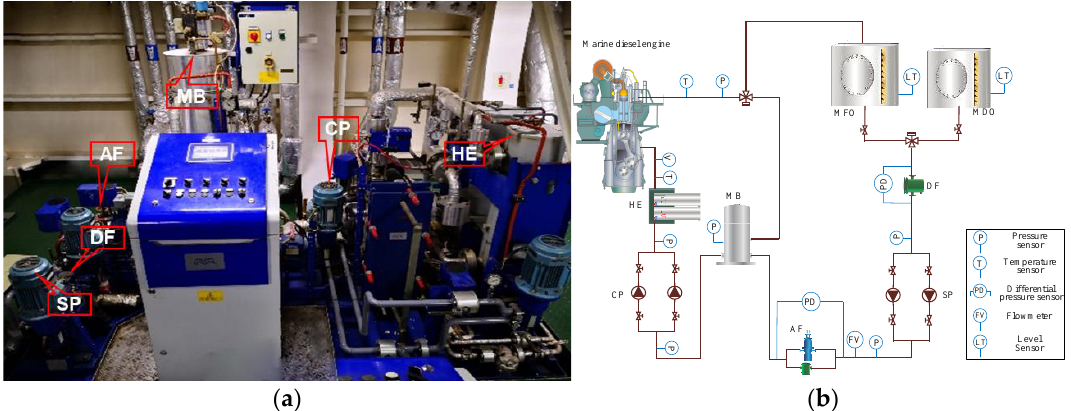
Figure 5. System structure diagram of FOSS: ( a ) structural diagram of real ship system; ( b ) system- schematic diagram.